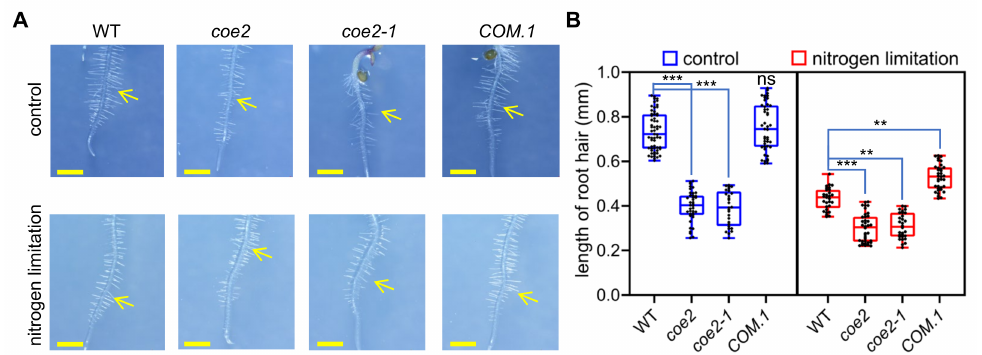
Figure 6. COE2 is involved in the regulation of root hair development in response to nitrogen availability. ( A ) Root hair growth status in coe2 , coe2-1 , COM.-1 , and WT grown on 1/2MS plates (control conditions) and 1/2MS plates containing 0.1 mM KNO3 (nitrogen limitation). Root hairs are indicated with yellow arrows. ( B ) Whisker box analysis of the length of root hairs in coe2 , coe2-1 , COM.-1 , and WT grown under control and nitrogen limitation conditions. The data were analyzed by